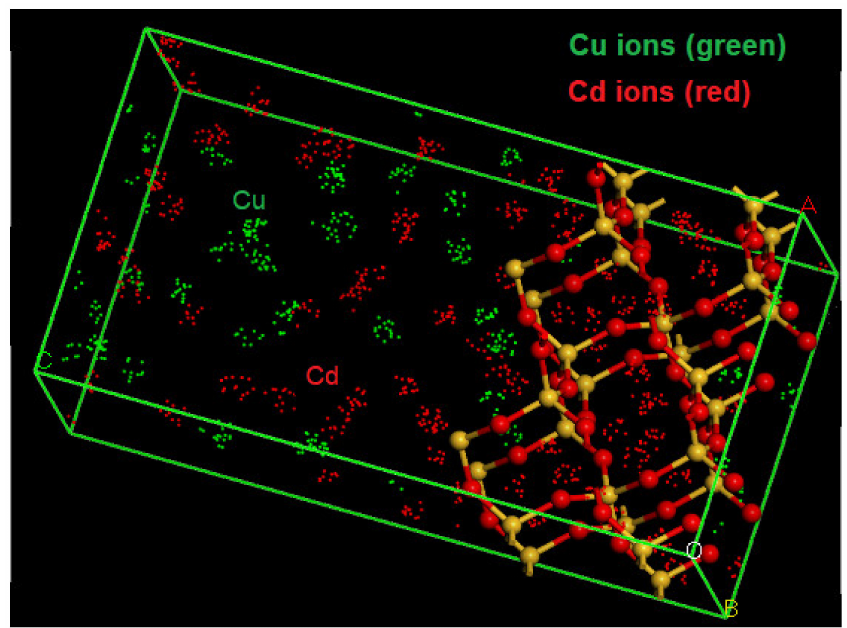
Figure 14. Unit cell loading of cadmium and copper